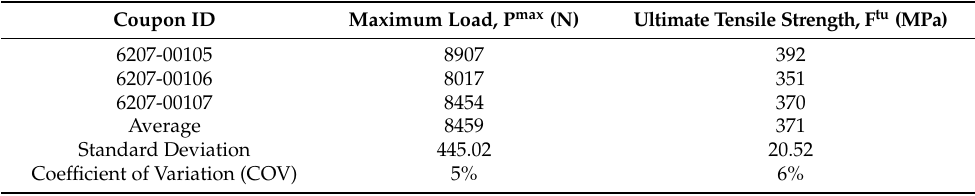
Table 2. Summary of the experimental results of the test coupons.